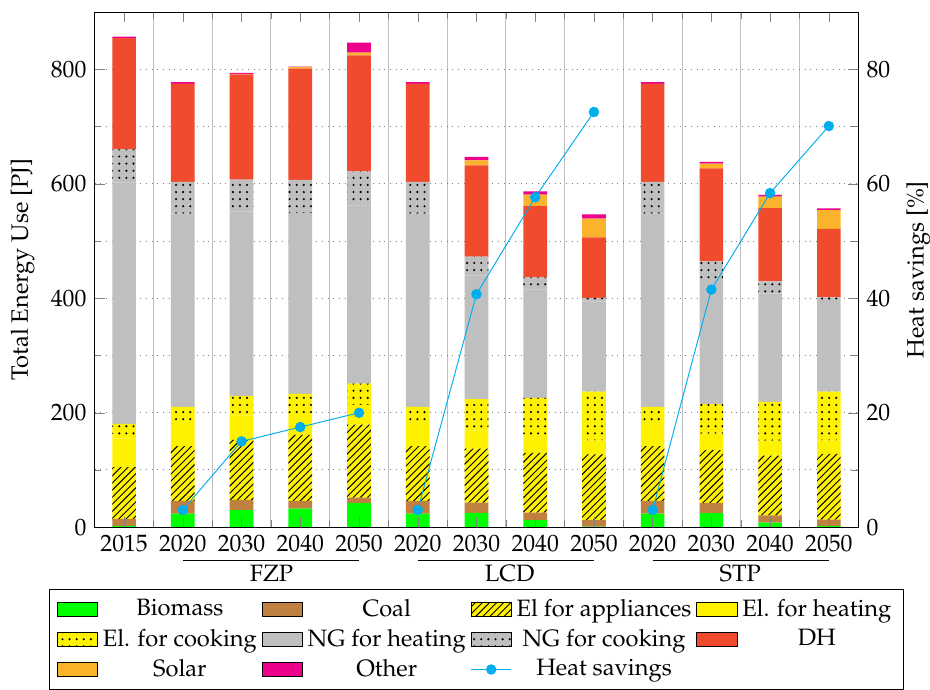
Figure 4. Final energy use in buildings by fuel type for three main scenarios.